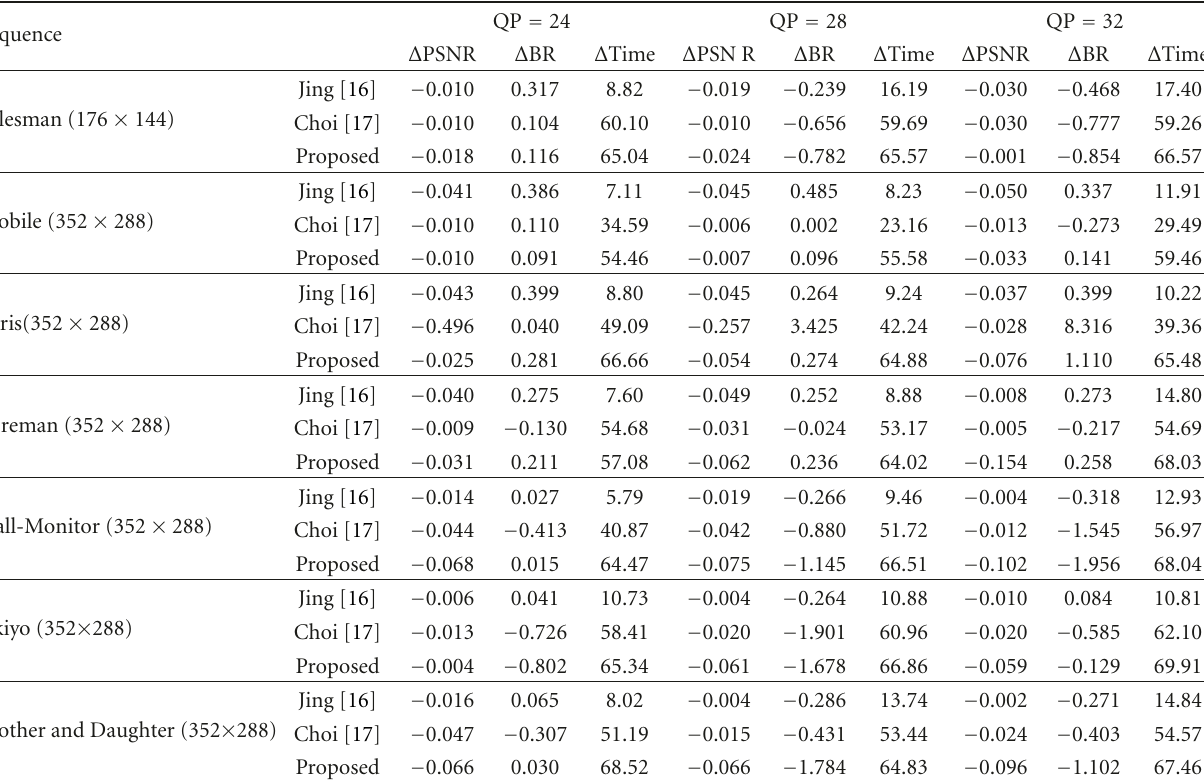
Table 1: Experimental results of the proposed algorithm.